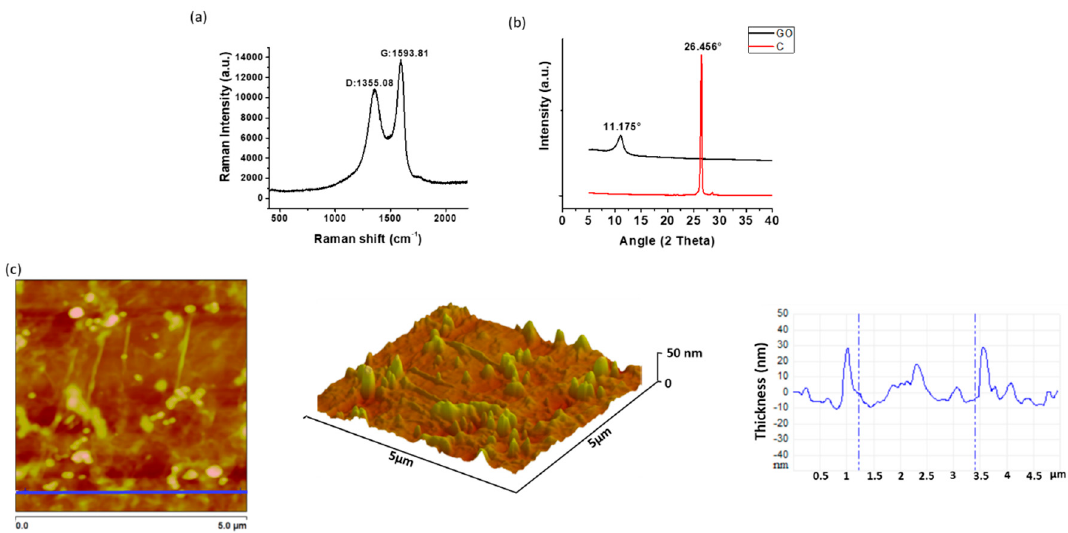
Figure 1. Characterization of GO by ( a ) Raman, ( b ) XRD (C is graphite), and ( c ) atomic force microscopy (AFM). Analysis of GO performed on tapping mode showing topography and thickness.